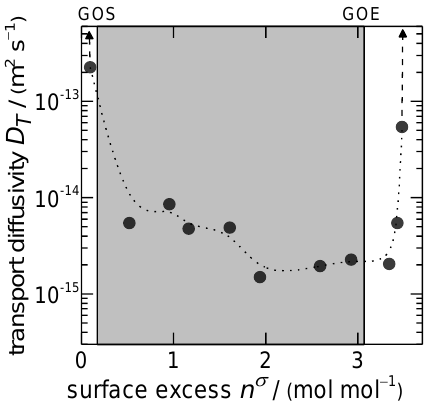
Figure 4. Transport diffusivities of n -butane on 1 in dependence of the loading. The grey area marks the loading range between gate-opening start ( GOS ) and gate-opening end ( GOE ). The arrows indicate much higher diffusivities in the regions of very low and very high pressures, which were not measurable under the experimental conditions.